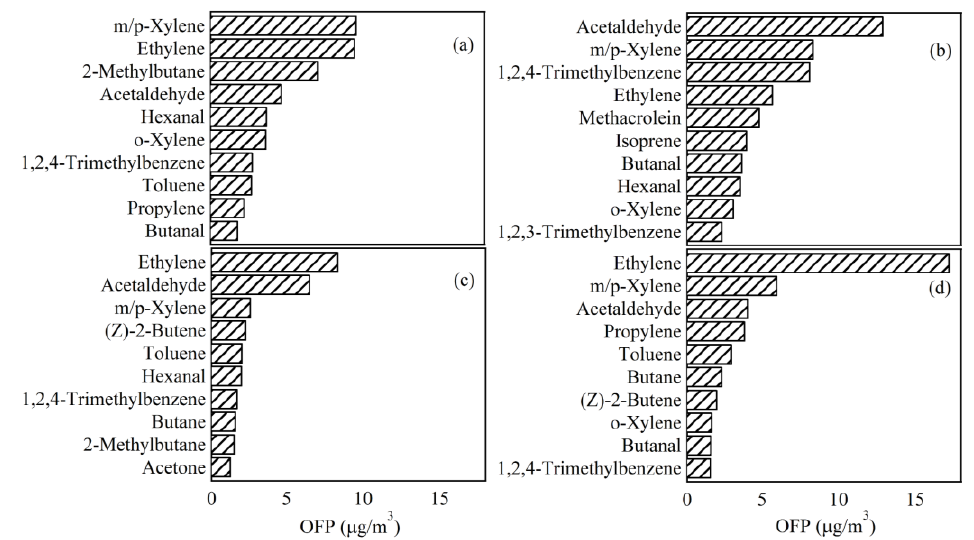
Figure 14. Top ten species of OFP in ( a ) spring, ( b ) summer, ( c ) fall, and ( d ) winter.